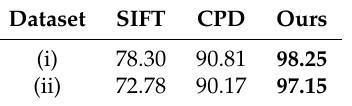
Table 3. Experimental results of series (I). Quantitative comparisons on the mean PR of Type I method are carried out. Bold fonts indicate the best results. All Units are in